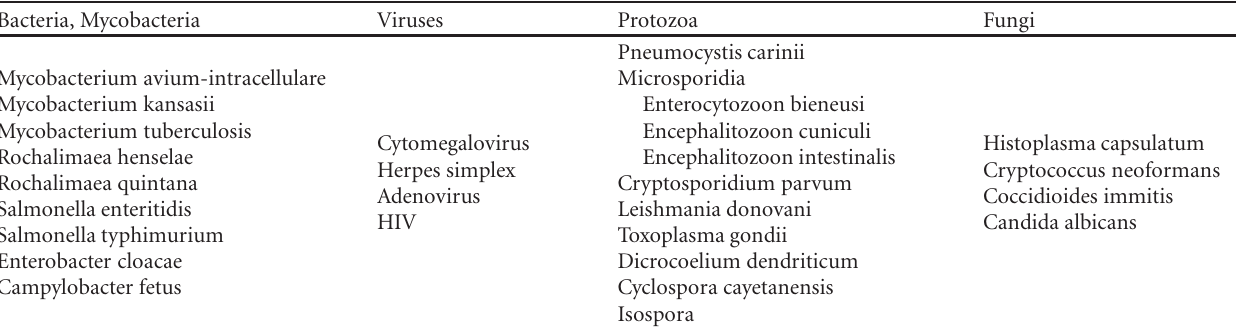
Table 1: Infectious causes of AIDS-associated cholangiopathy.